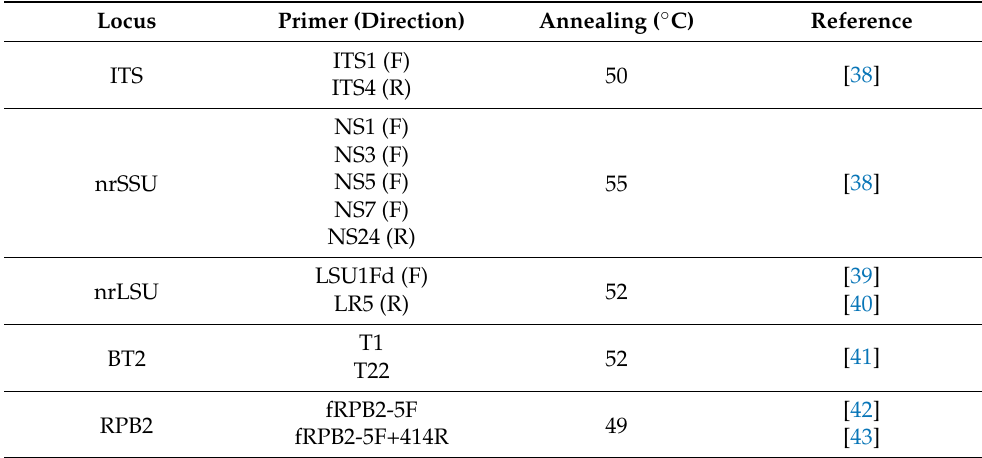
Table 1. Multi-locus primers used for the identification of Pseudotaeniolina globosa from literature. Locus Primer (Direction)